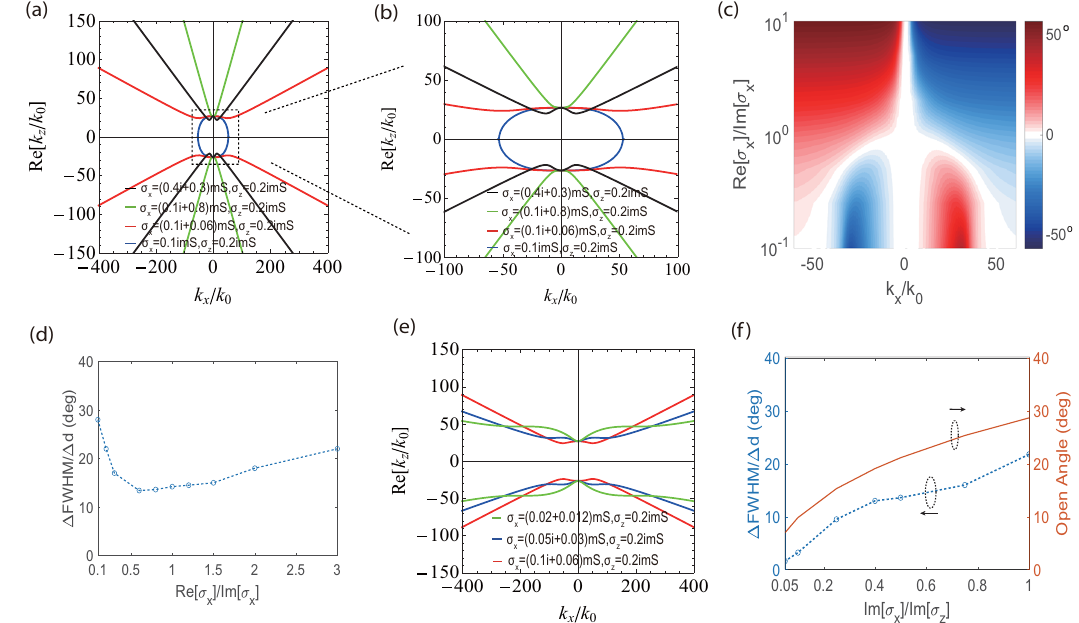
Fig. 2 Flatband dispersion in anisotropic 2D materials. a Dispersion curves of anisotropic 2D materials using various combinations of Re σ x ½ (cid:3) , and Im σ x ½ (cid:3) , which can support elliptic, hyperbolic and mixed type of dispersion by regulating material absorption, allowing contour to transition from close to open. b Detailed view of the dispersion curves shown in ( a ). It is seen that when Re σ x ½ (cid:3) (cid:4) Im σ x ½ (cid:3) , the dispersion curve can be fl attened in the regime where (cid:1) 100 <k x = k 0 < 100 as a result of mixed type of dispersion. c The angle of the direction of Poynting vector ( ∂ k z = ∂ k x ) of k x modes as a function of material absorption with respect to z -axis. When Re σ x ½ (cid:3) (cid:4) Im σ x ½ (cid:3) , the angle of Poynting vector can become zero over a broad range of k x , permitting canalization to occur. d Numerically simulated diffraction angle 21 of the fi eld propagation in anisotropic 2D materials (Im[ σ x,z ] = 0.1,0.2imS) as function of material absorption ( Re σ x ½ (cid:3) = Im σ x ½ (cid:3) ) launched by a dipole source. The dipole source is pointing in the out-of-plane ( y ) direction and will excite all k x spatial harmonics. It is seen that the diffraction can be best suppressed when Re σ x ½ (cid:3) (cid:7) 0 : 6Im σ x ½ (cid:3) . e Dispersion curves in anisotropic 2D materials with varying degree of in-plane anisotropy ( Im σ z ½ (cid:3) = Im σ x ½ (cid:3) ) while using the same strength of material absorption ( Re σ x ½ (cid:3) ¼ 0 : 6Im σ x ½ (cid:3) ). It is shown that on top of material absorption, it is possible to further fl atten dispersion curve with the aide of more extreme material ’ s anisotropy. (f) Diffraction and open angels of the propagating fi elds in anisotropic 2D materials ( Im σ x ½ (cid:3) ¼ 0 : 2 mS and Re σ x ½ (cid:3) ¼ 0 : 6Im σ x ½ (cid:3) )) as a function of in-plane anisotropy launched by a y-directed dipole source. Diffraction can be further suppressed by decreasing the value of Im σ x ½ (cid:3) = Im σ z ½ (cid:3) as a result of more fl atted dispersion enabled by